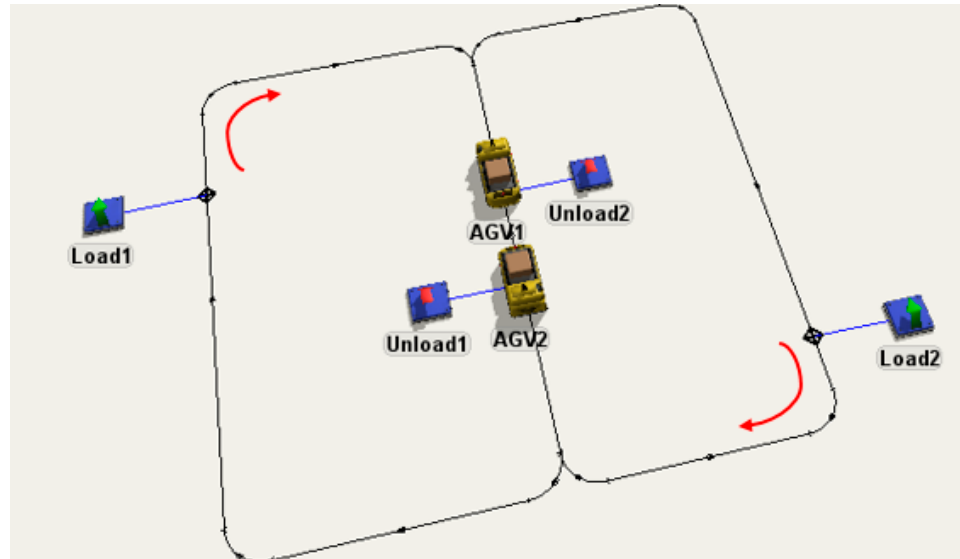
Figure 14. Case IV: Screenshot of the bridge crossing deadlock problem represented in FlexSim.